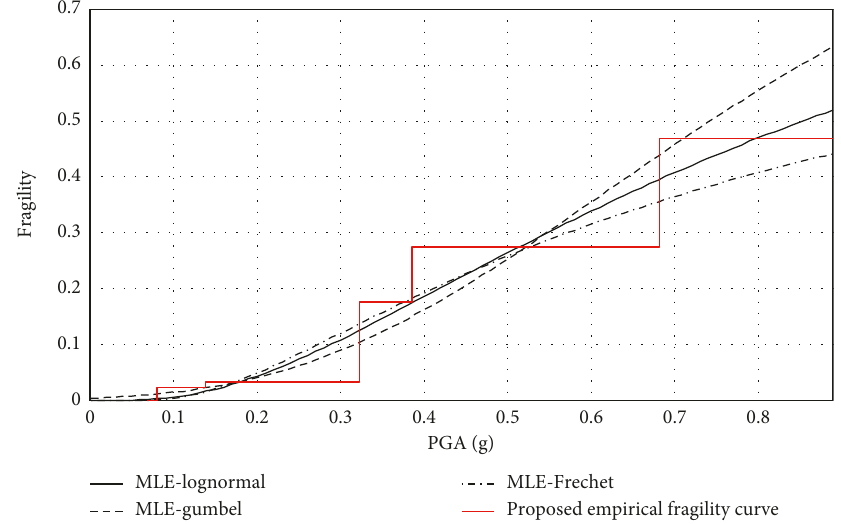
Figure 7: Comparison of empirical fragility curves of damage state with